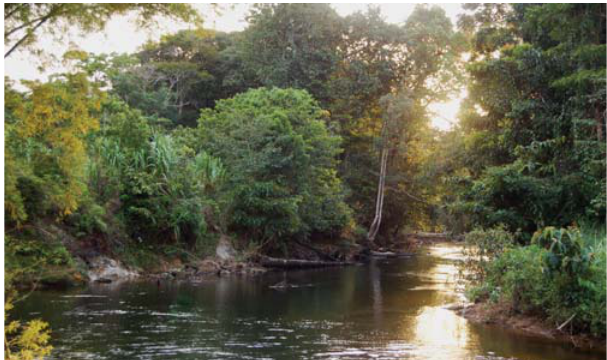
Fig. 4. Neblinichthys habitat in the Kukui River at Philipai 05º21’37”N 60º22’18”W.